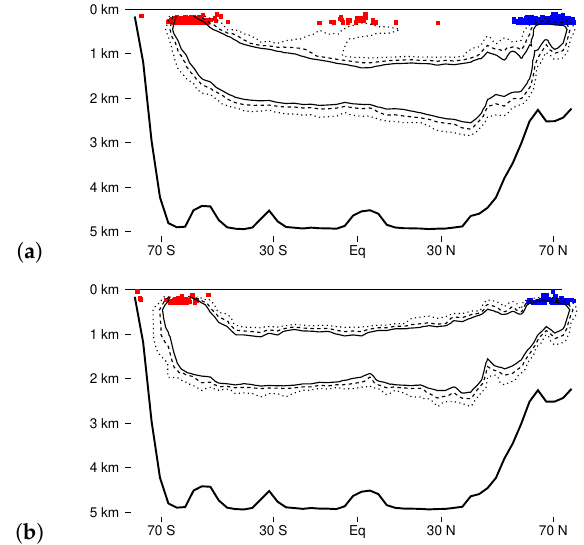
Figure 13. Vertical cross-section of pathway to upwelling of North Atlantic Deep Water. ( a ) Simulation with mixing. ( b ) Simulation without mixing. Blue (red) dots indicate downwelling (upwelling) locations. Contouring indicates the percent of WME pathways that pass through each 3 degree by 300 m grid box (10, 30, and 50 percent).